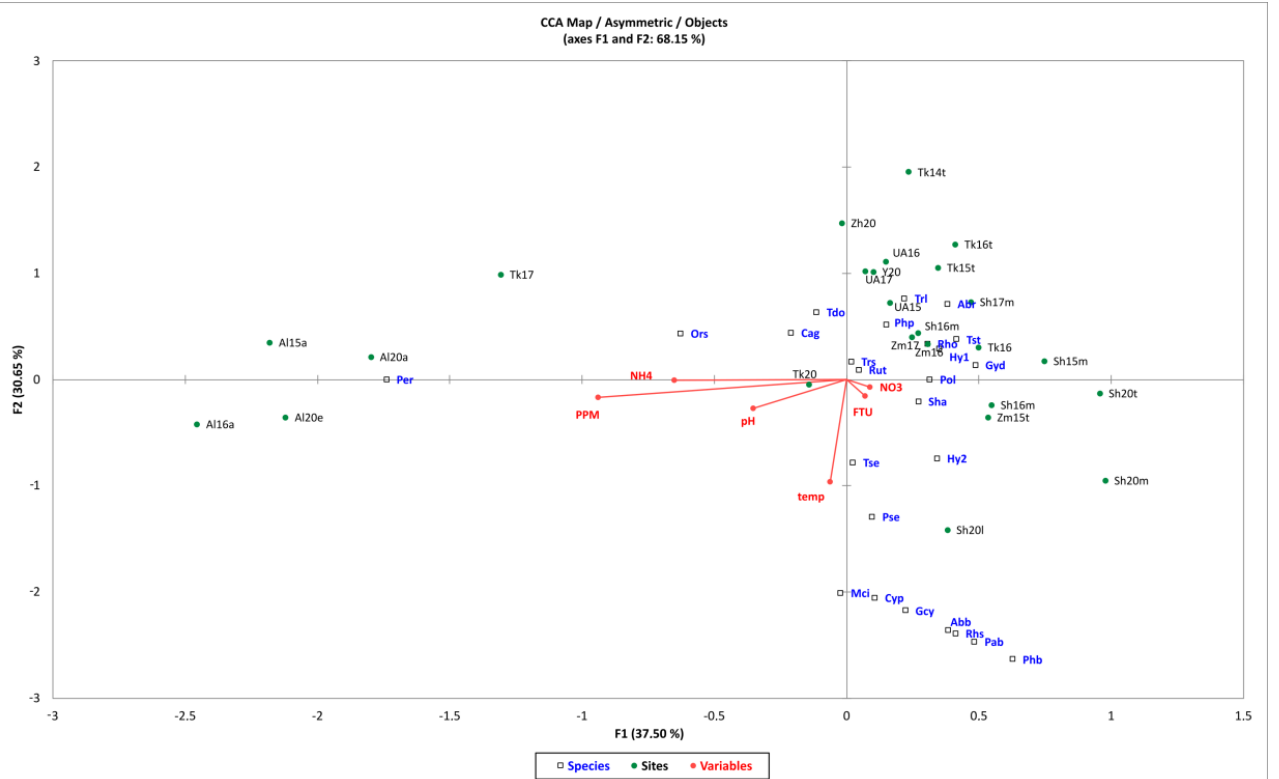
Figure 4. CCA plot of species (objects), sites and environmental variables of water bodies in the Alakol Lakes watershed: first axis horizontally, second axis vertically. Abbreviations of sites are given in Table 2 and species in Table 4. Abbreviations of the environmental arrows are PPM—water miner- (formazin turbidity unit), NH 4 and NO 3 concentrations of ammonia and nitrates,